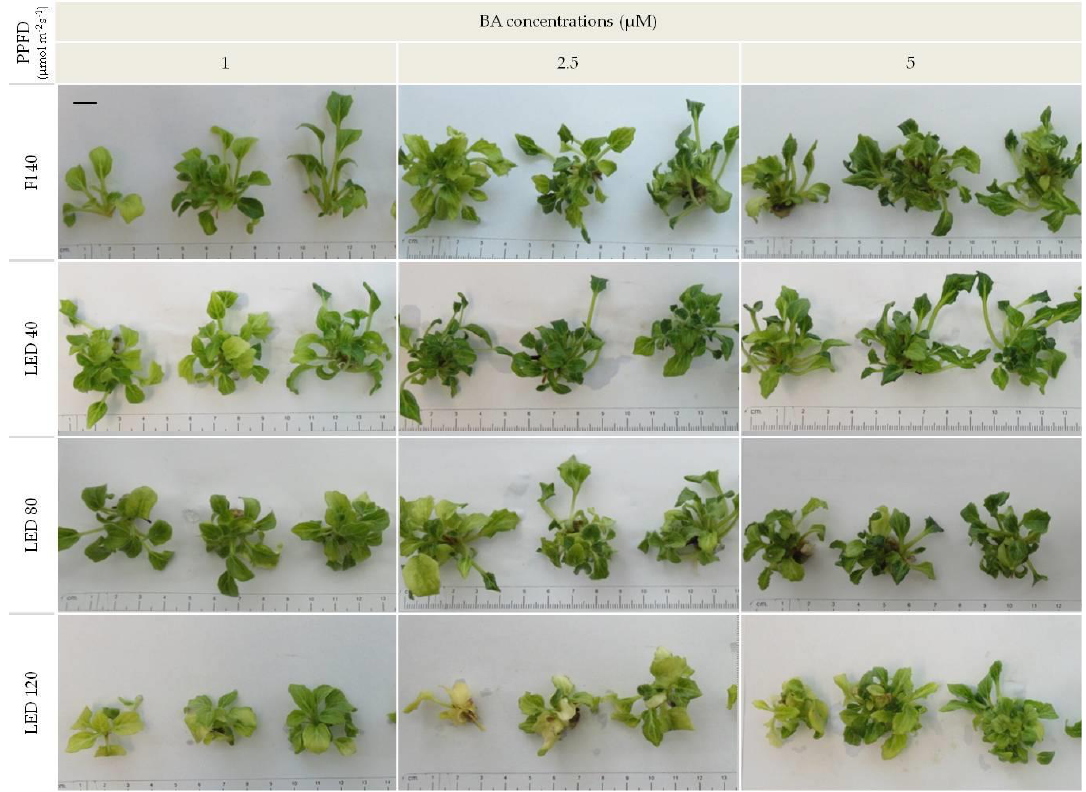
Figure 2. Gerbera jamesonii plantlets after six weeks of in vitro culture on Murashige and Skoog (MS) medium with various 6-benzyladenine (BA) concentrations and different photosynthetic photon flux densities (PPFDs). Fl 40 — control, fluorescent Philips TK-D 36W/54 lamps. LED 40, LED 80, LED 120 — combination of red (70%) and blue (30%) light emitted by light-emitting diodes with 40, 80, and 120 µmol m −2 s −1 PPFD, respectively.